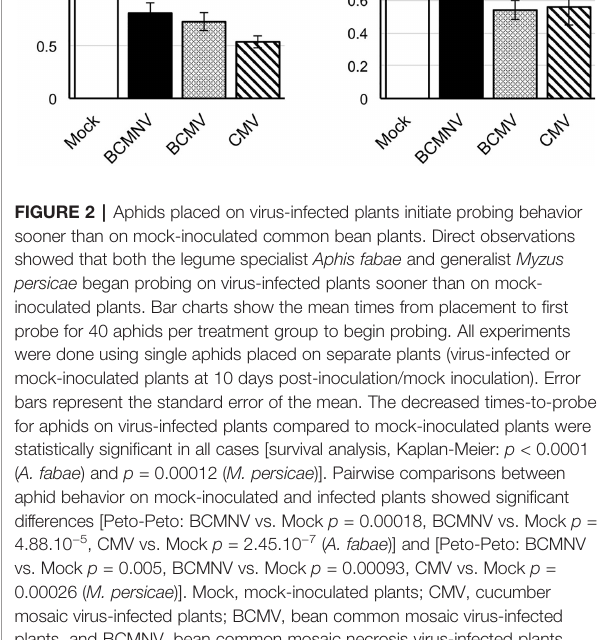
pairwise comparisons of A. fabae on CMV-infected compared with mock-inoculated plants were highly signi fi cant [Pairwise Peto-Peto: p = 0.0099 ( Figure 5B , Supporting Information: Excel File 3 )]. By comparison, there were no appreciable